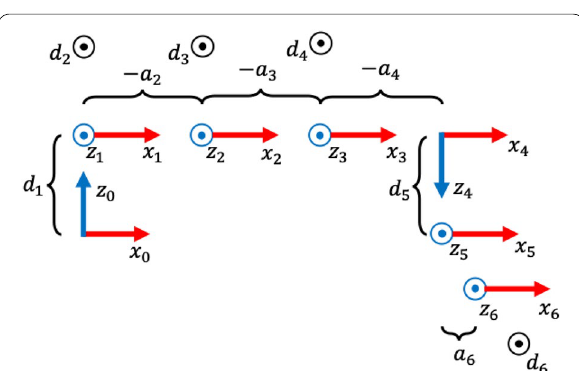
Fig. 4 UR3 Denavit Hartenberg parameters